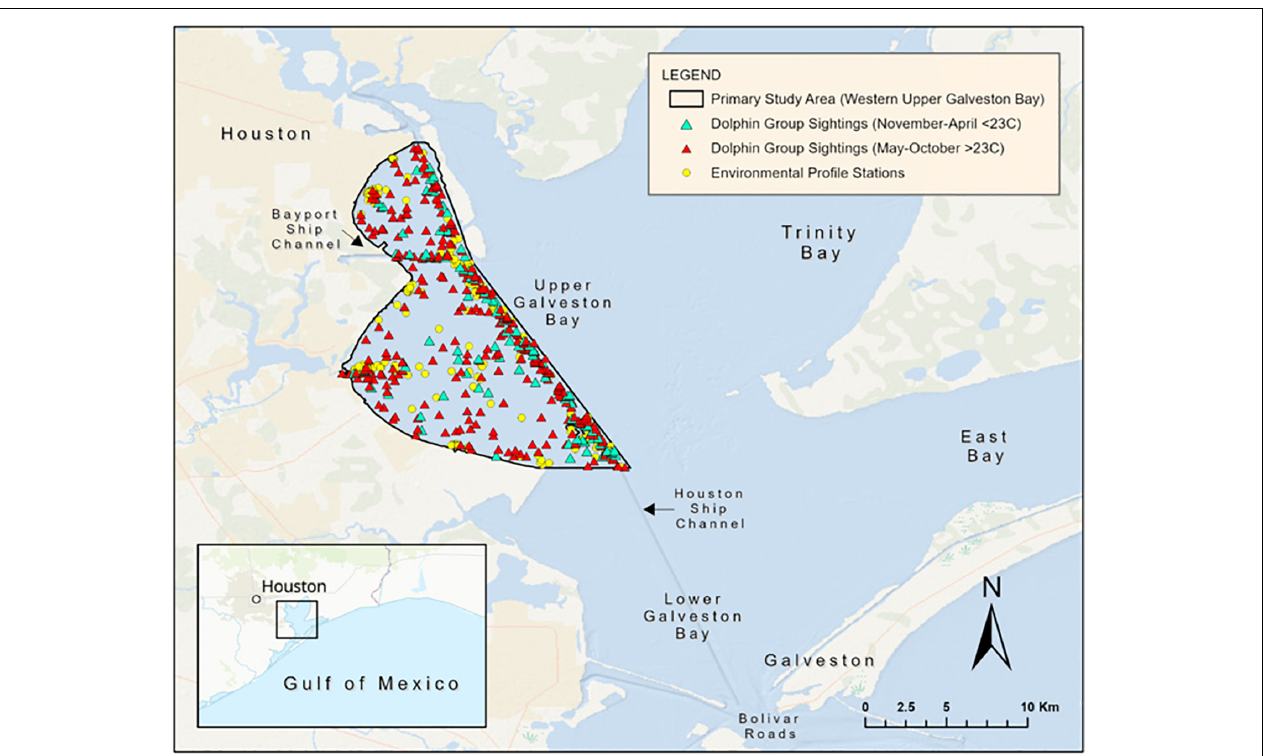
FIGURE 1 | Map of the primary study area in western upper Galveston Bay, Texas. Dolphin group sightings from January 2016 to December 2019 are displayed, as well as “Environmental Profile Stations” where mid-column water temperature and salinity were recorded. GIS layers: Esri, DeLorme, and NaturalVue.